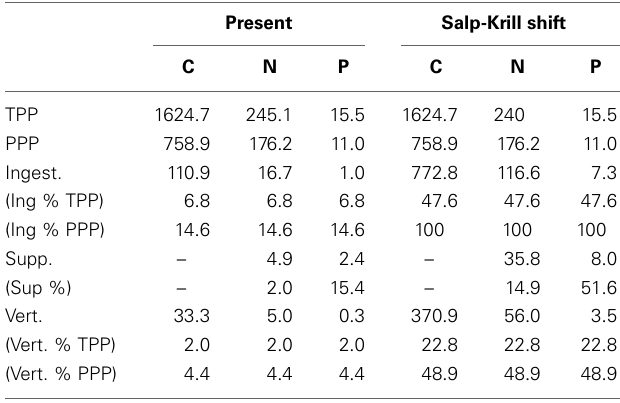
Table 5 | Allocation and fate of biogenic C, N, and P during our study ( Present ) and in the case of the predicted Salp-Krill shift .